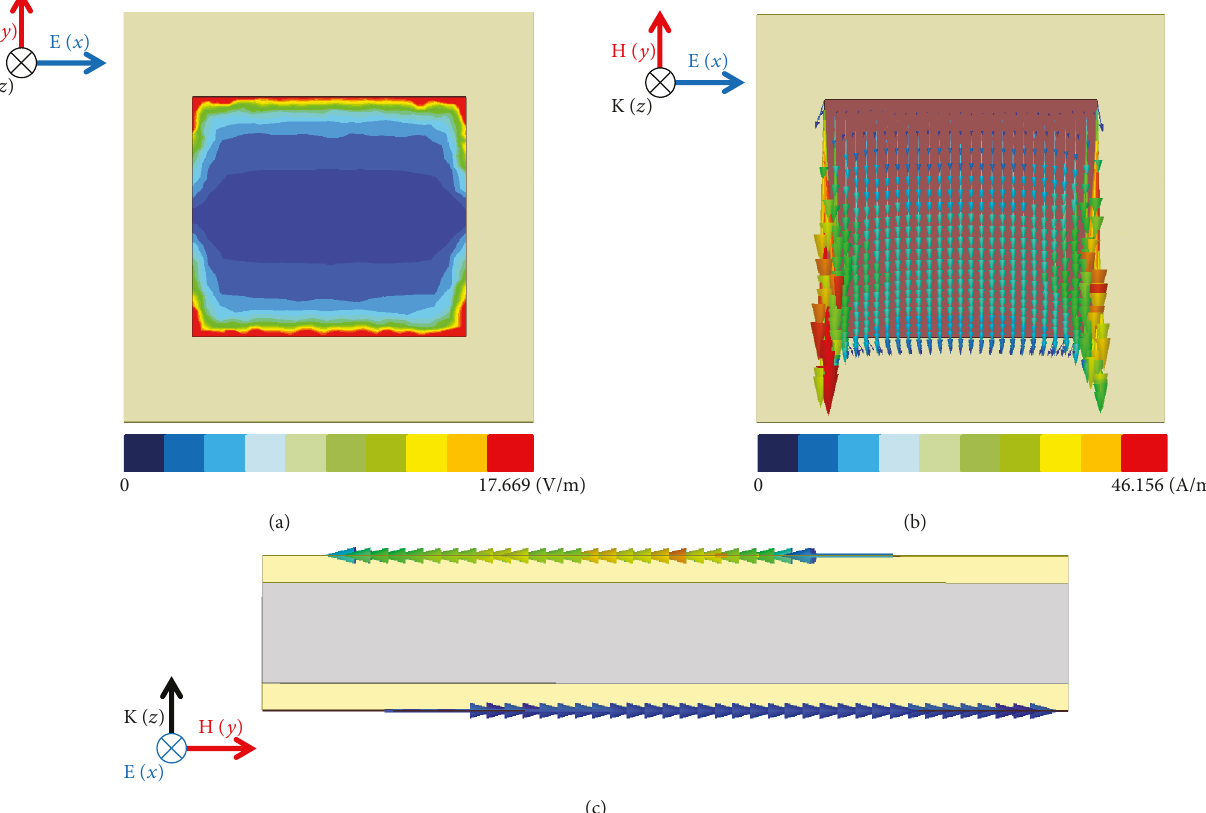
Figure 3: (a) Simulated electric fi eld distribution; (b) top and (c) side view of the vector current density of the proposed